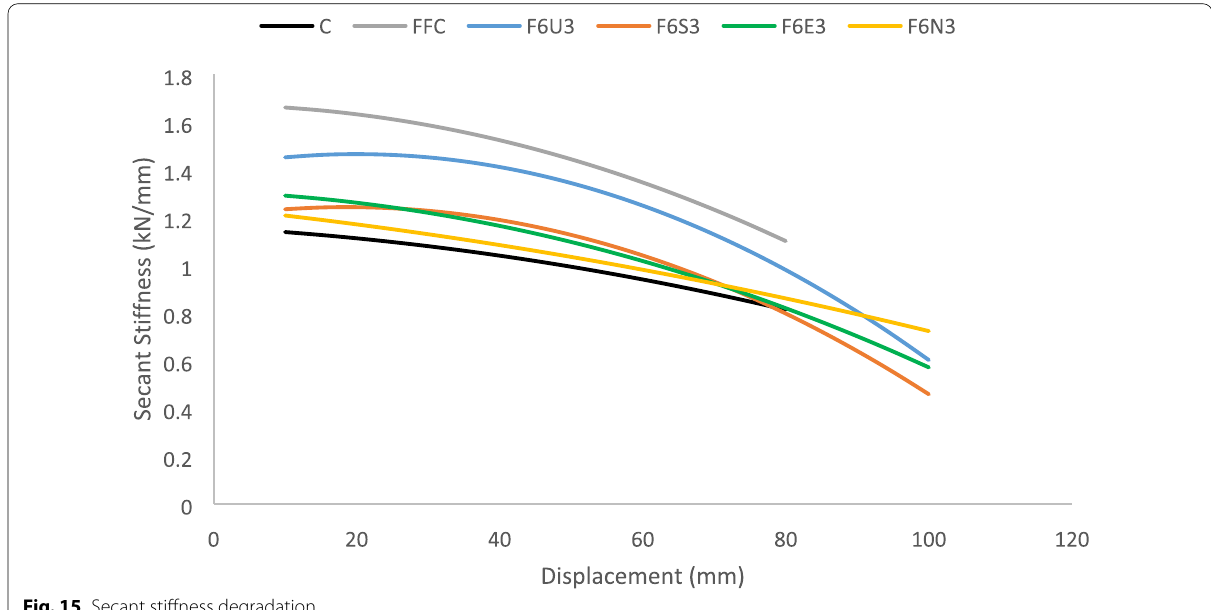
Fig. 15 Secant stiffness